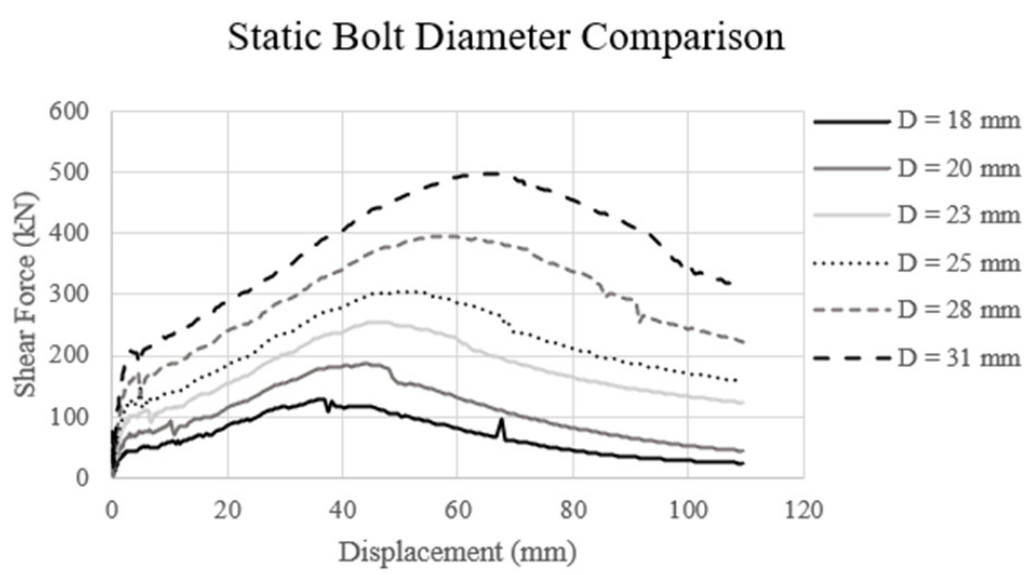
Figure 18. Bolt diameter force vs. displacement comparison for f y = 922 MPa.